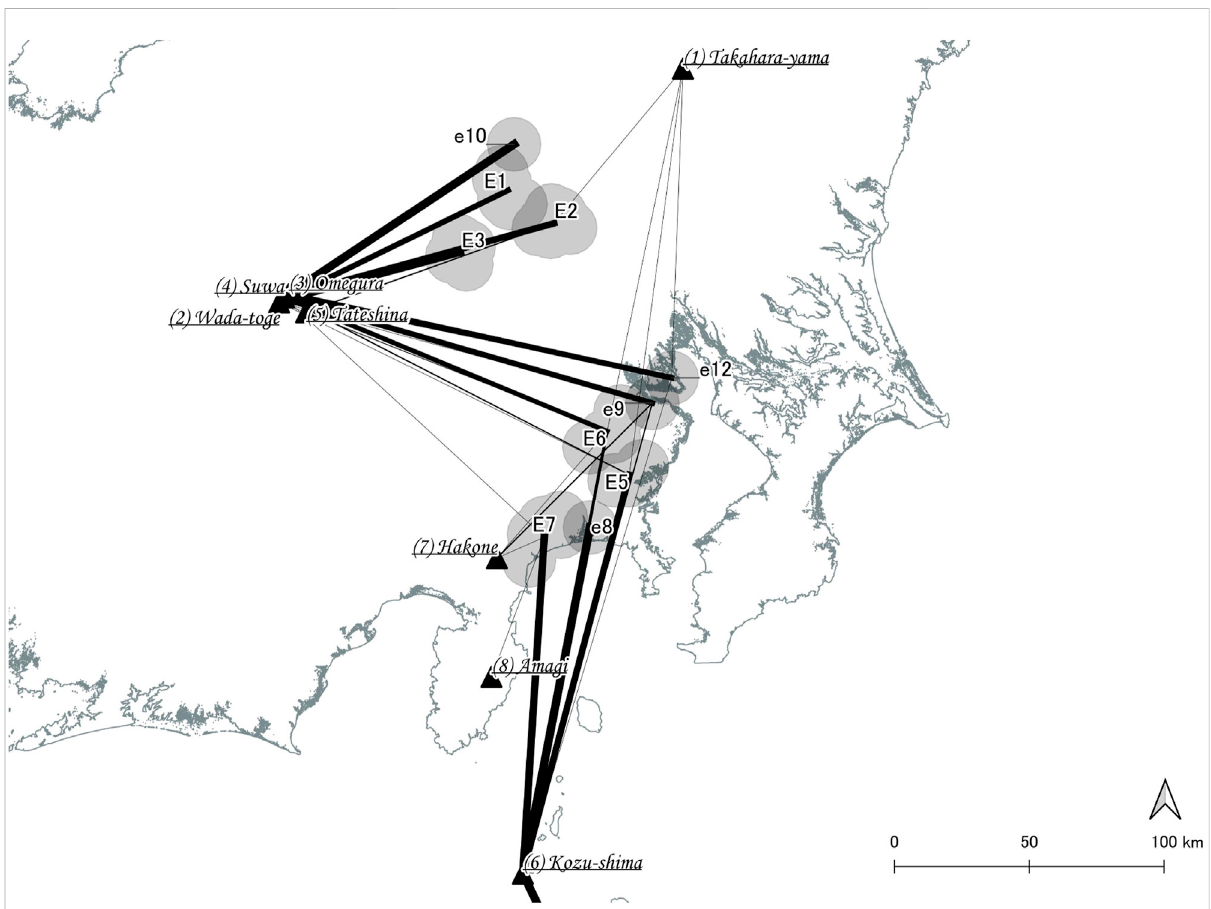
FIGURE 4 Bipartite graphs between provenance and consumption areas in Period 2, the early Jomon period (7,000 – 5,500 years cal BP). Clusters are represented by uppercase characters and single sites by lowercase characters. The thickness of the links corresponds to the composition ratio of each production area in each cluster (E1 – 3, 5 – 7) and each single site (b8 –